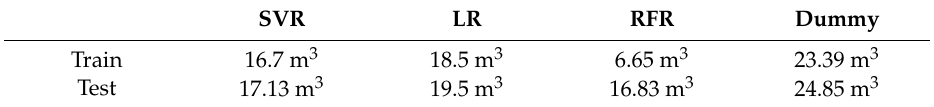
Table 2. Root-mean-square error (RMSE) of 90-10 shu ffl e cross-validation for the models (m 3 ha − 1 week − 1 ). LR: linear regression; RFR: random forest regression; SVR: support vector